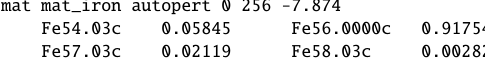
Figure 2. Iron material definition with 256 di ff erent ACE files